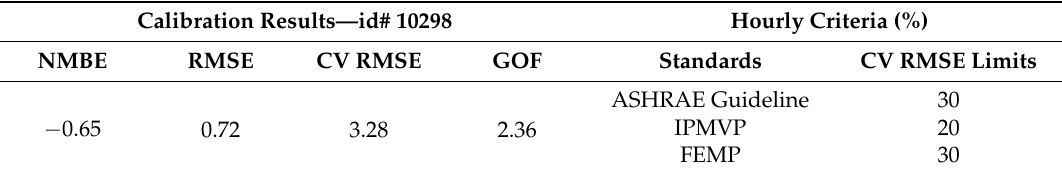
Table 4. Acceptance criteria used for building energy model (BEM) calibration—id. 10298. Calibration Results—id#